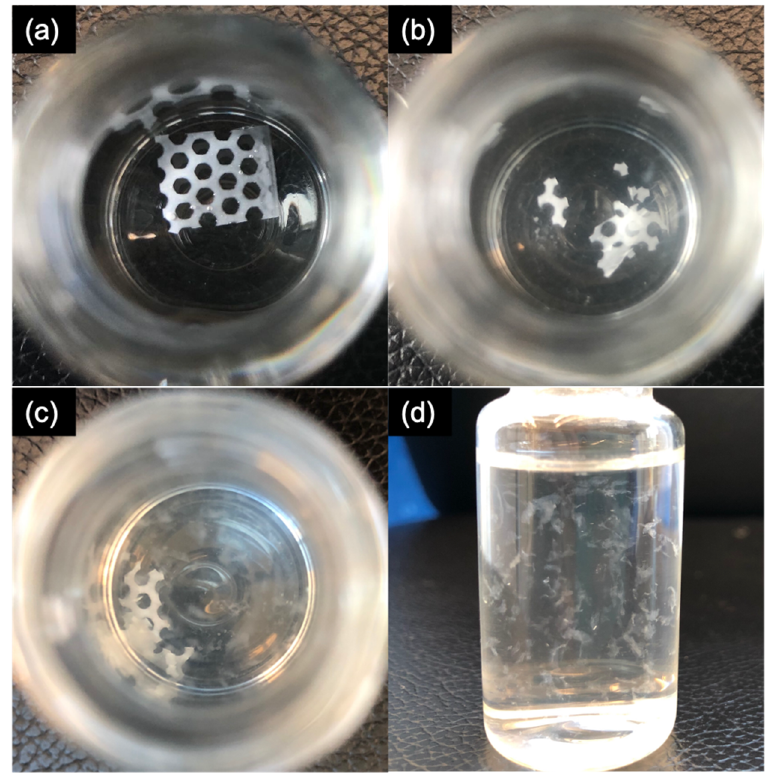
Figure 12. ( a ) Top view of blank PCL scaffold at the start of incubation; ( b ) top view of blank PCL scaffold after six-month incubation; ( c ) top-view of blank PCL scaffold after eight-month incubation; ( d ) side-view of blank PCL scaffold after eight-month incubation.